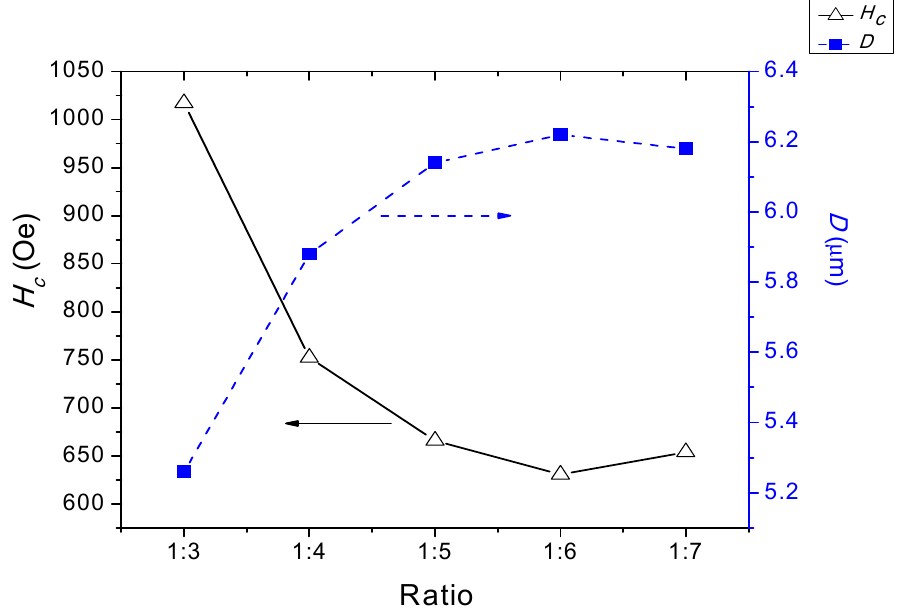
Figure 8. Grain size, D , and coercivity, H c , of BaFe 12 O 19 at different ratios.